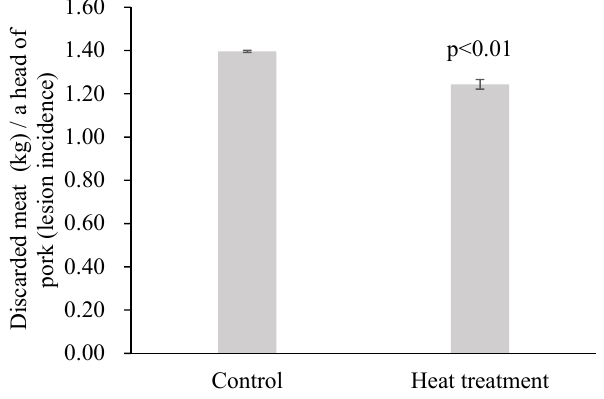
Figure 4. Amount of discarded meat (kg) per a head of pigs with lesions injected with foot-and-mouth disease vaccine after heat treatment at 40°C for 20 min. Error bars are standard error.